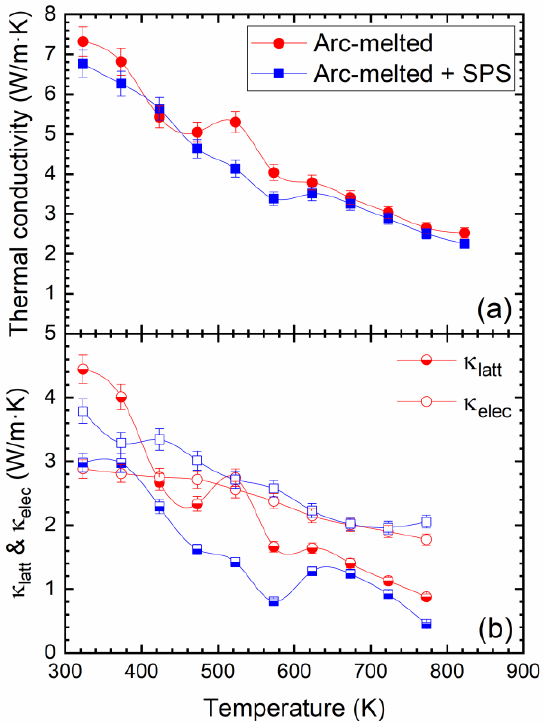
Figure 9. Temperature dependence of the ( a ) total thermal conductivity and ( b ) lattice and electronic contributions.